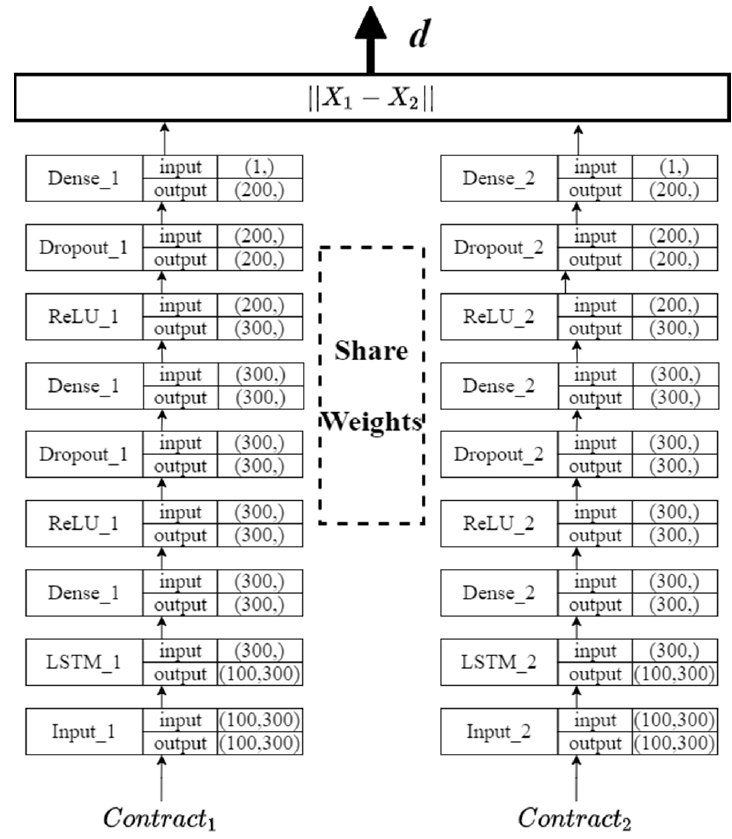
Figure 5. Siamese network structure.